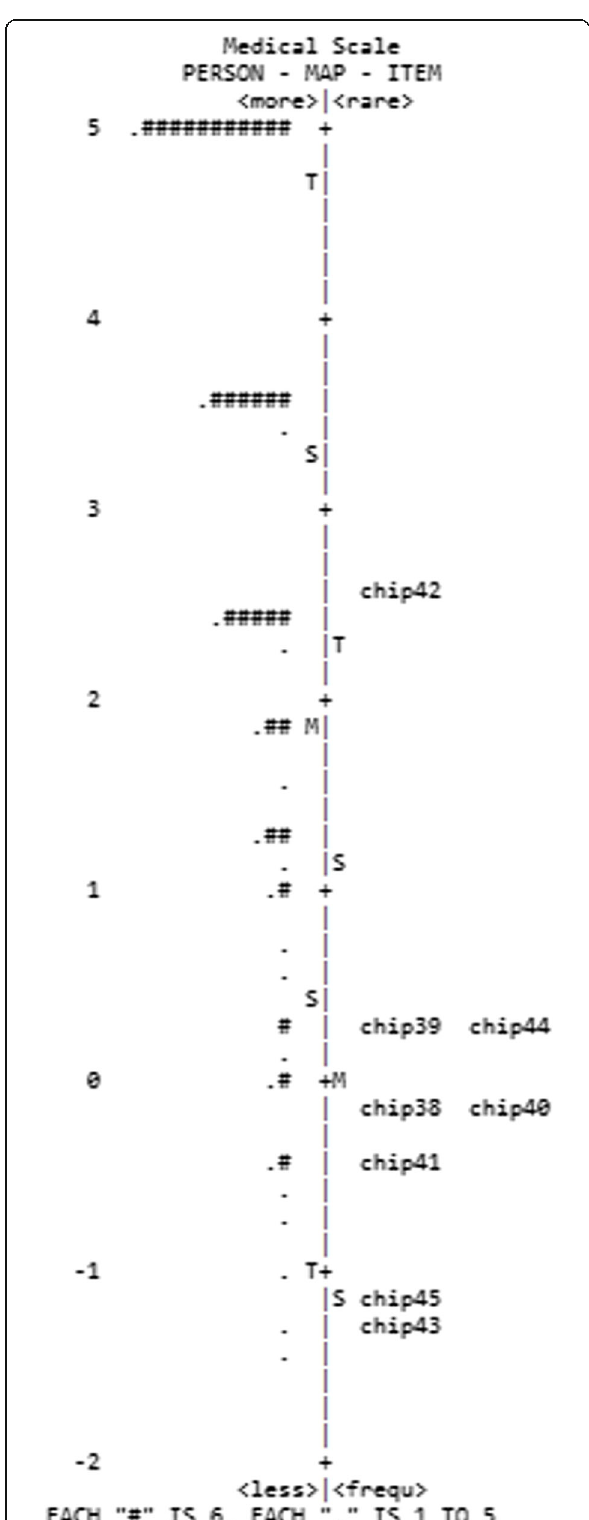
Fig. 2 Item-person map for the support dimension of the CHIP